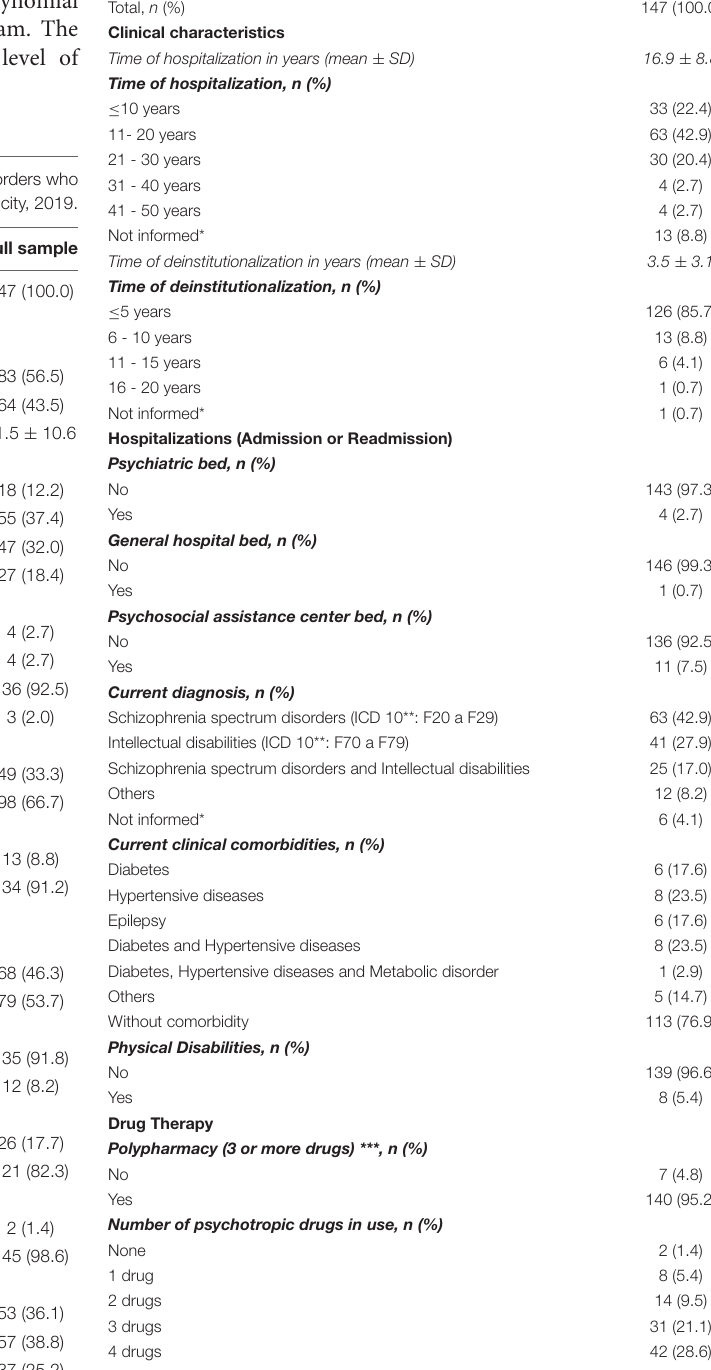
TABLE 2 | Clinical characteristics of people with mental disorders who underwent deinstitutionalization using assisted living facilities, Sorocaba city,